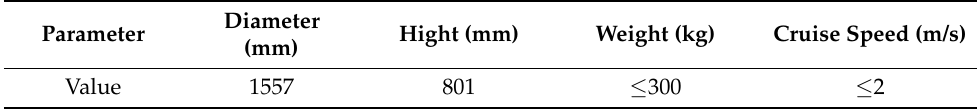
Table 1. Basic parameters of the current AUH (the HG1